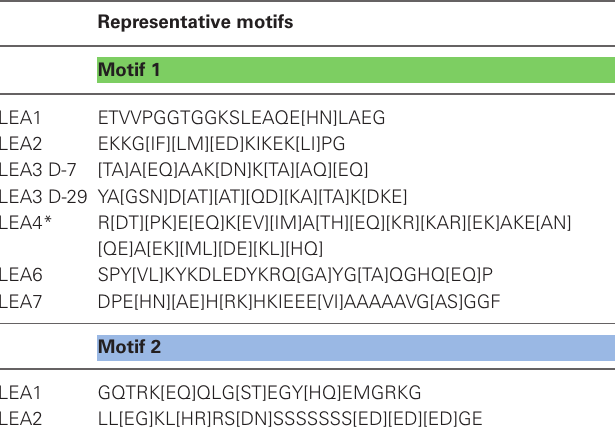
Table 2 | Distinctive motifs in the different groups of legume LEA